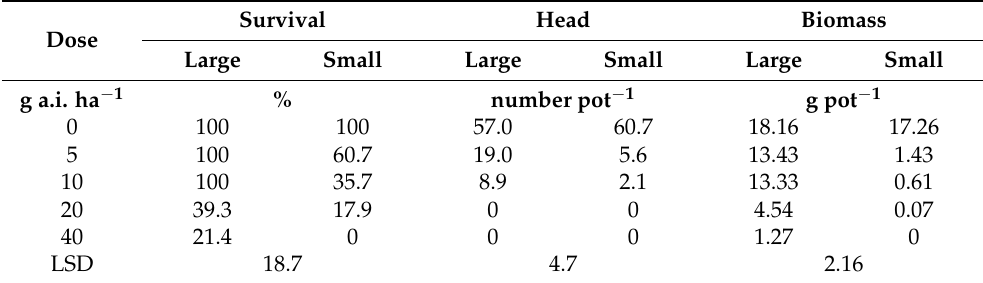
Table 5. The interaction effect of the growth stage (small, 10–12 cm in height and 14–18 leaf stage; and large, 28–30 cm in height and 60–70 leaf stage) of Navua sedge and azimsulfuron dose on the survival, head number, and biomass of the